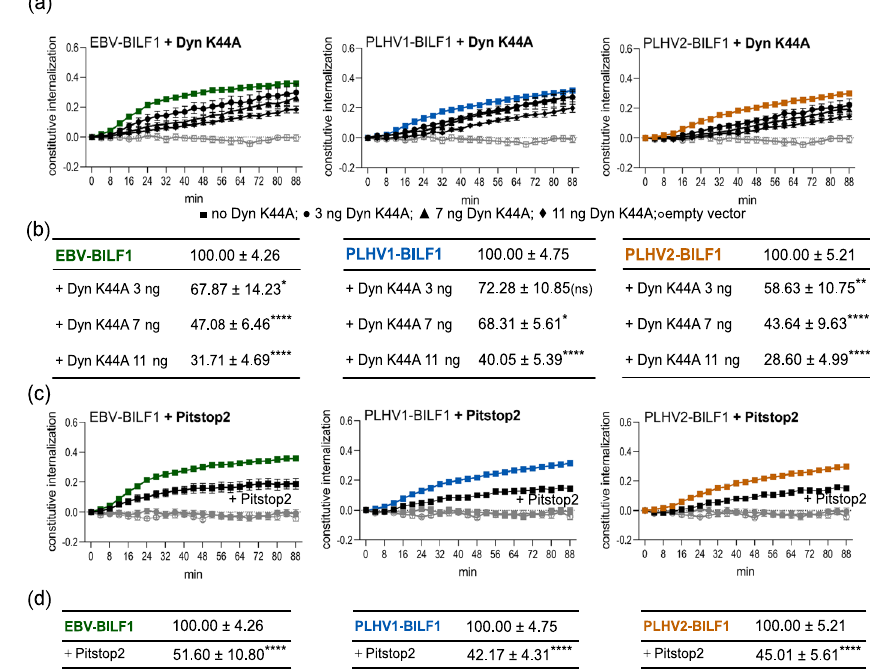
Fig. 2 Internalization of BILF1 receptors depends on dynamin-1 and clathrin. SNAP-tagged EBV-BILF1 (green), SNAP-tagged PLHV1-BILF1 (blue), SNAP-tagged PLHV2-BILF1 (orange), and empty vector (gray) were expressed in HEK-293A cells and were either a co-transfected with different concentrations of Dyn K44A DNM (black circle 3 ng; black up-pointing triangle 7 ng; black diamond 11 ng) or c incubated with 5 µM Pitstop2 inhibitor (black circle or white circle for empty vector) or internalization buffer as a control (black square). Labeling with donor SnapLumi4-Tb was performed at 4 °C to prevent internalization prior to measurement. Internalization was measured every 4 min for 88 min at 37 °C. The graph curves represent the ratio between donor and acceptor. b , d The area under the curve (AUC) was calculated for each graph and was normalized to the AUC of each BILF1 receptor without addition of the Dyn K44A or Pitstop2 (100%) and empty vector (0%). Statistical differences were determined using Dunnett’s multiple comparisons two-way ANOVA test. * P < 0.05, ** P < 0.01, *** P < 0.001, **** P <